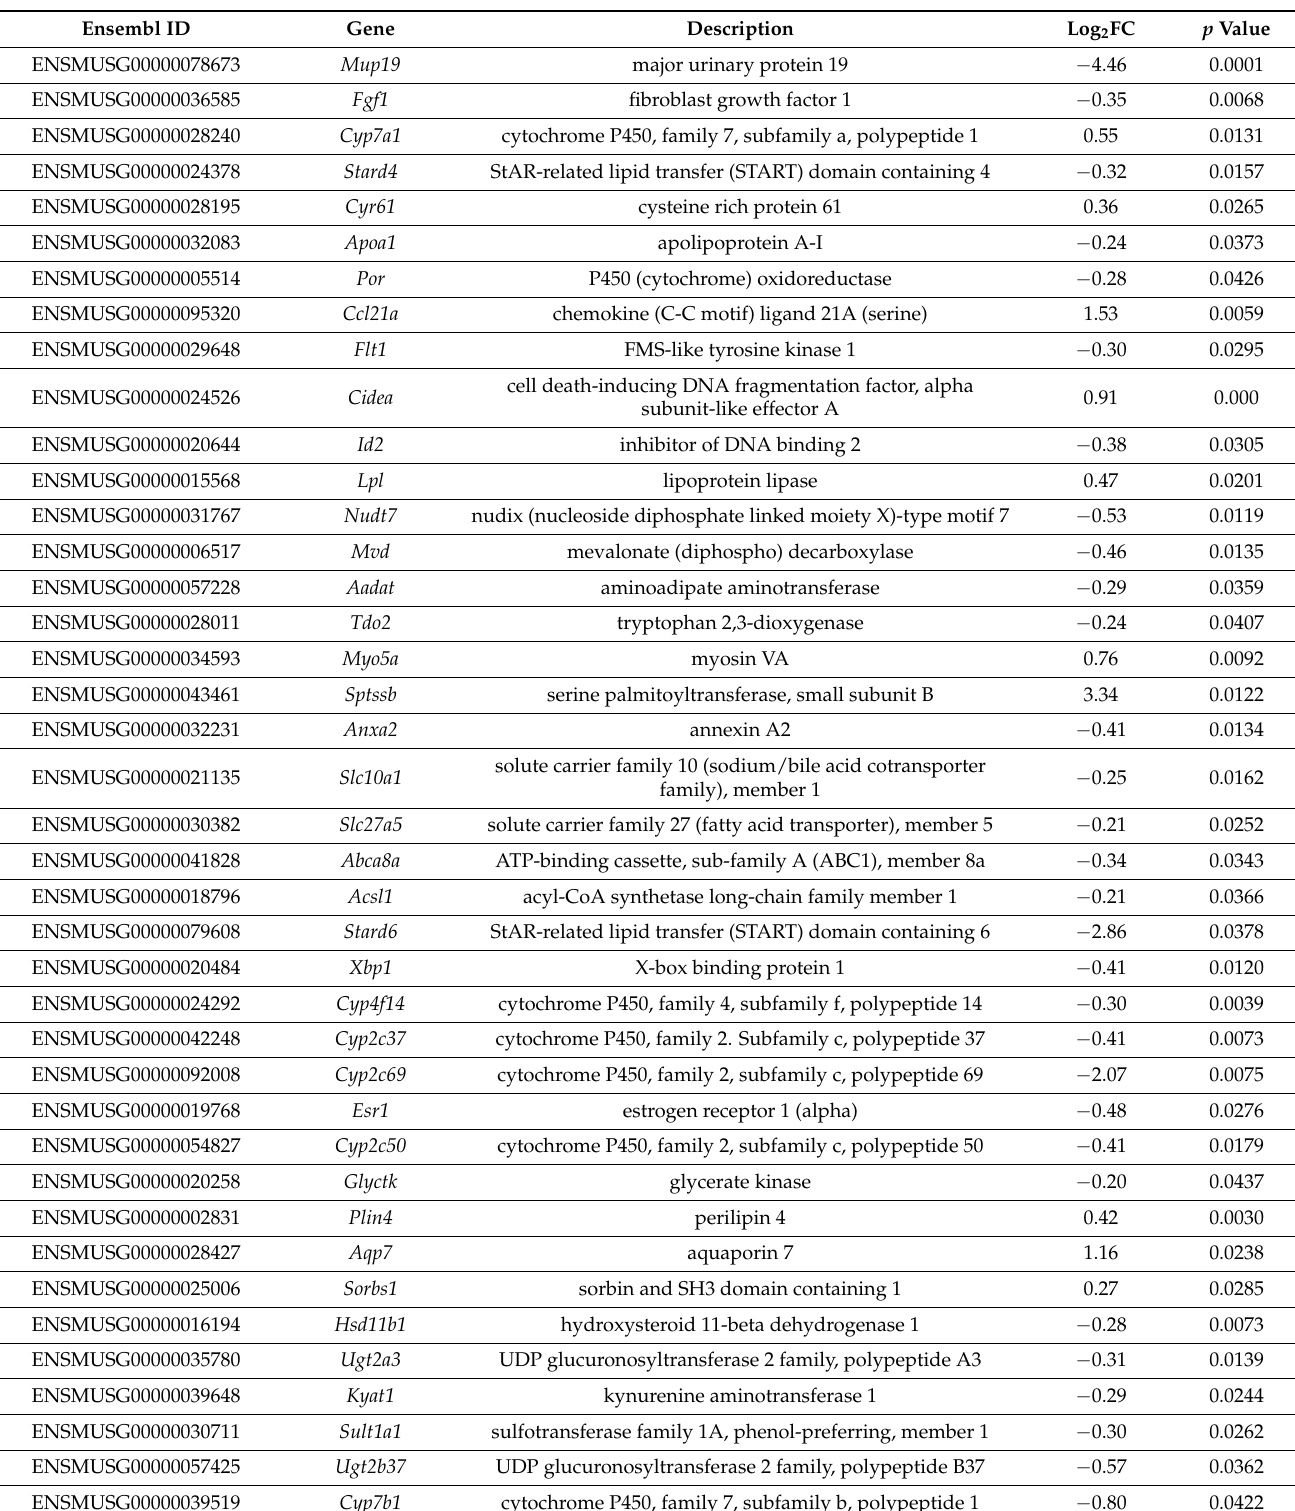
Table 1. DEGs related to lipid and glucose